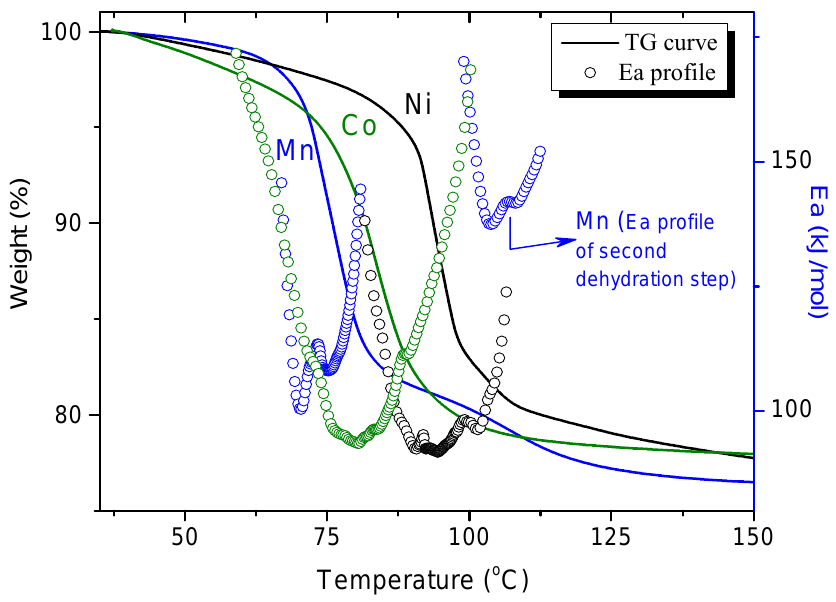
Figure 2. Thermogravimetric curves and activation energies profiles for the